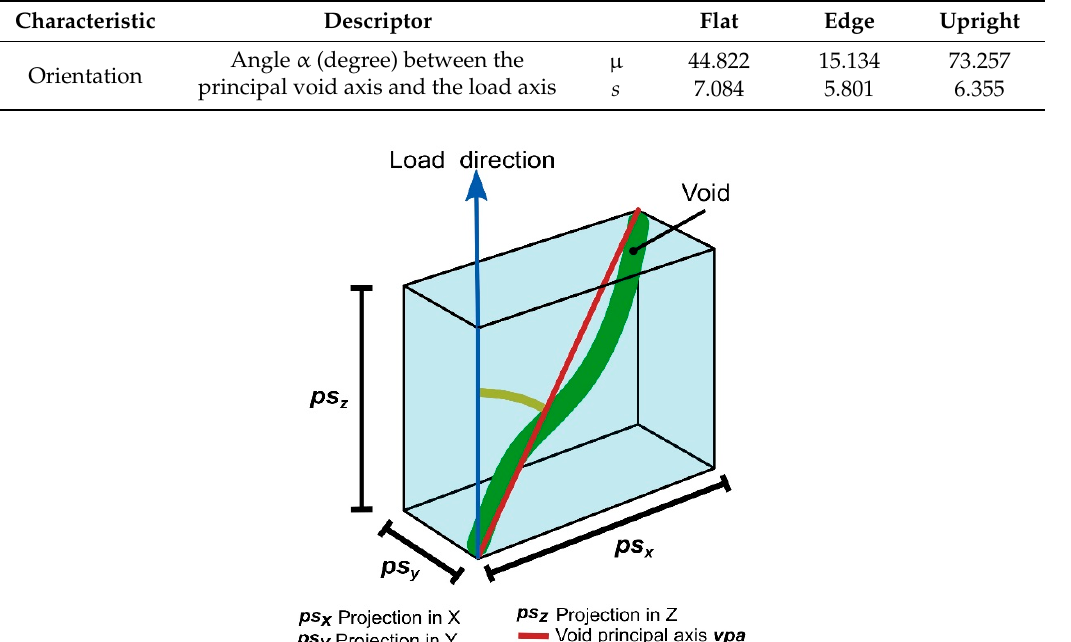
Table 2. Mean ( µ ) and standard deviation ( s ) of void orientation angle according to build direction.